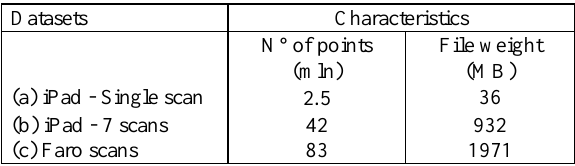
Table 1 . Characteristics of the acquired point